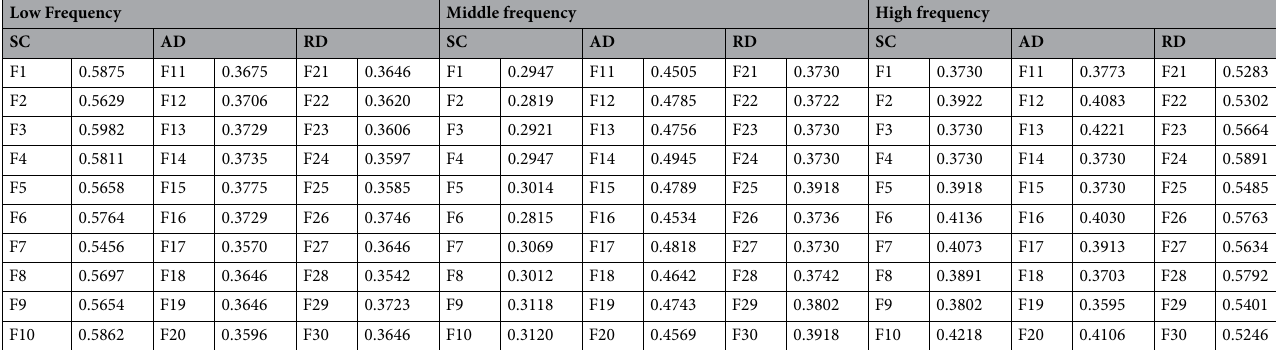
Table 5. Extraction of lower bounds for SC, AD and RD fault conditions in pre-defined frequency bands.